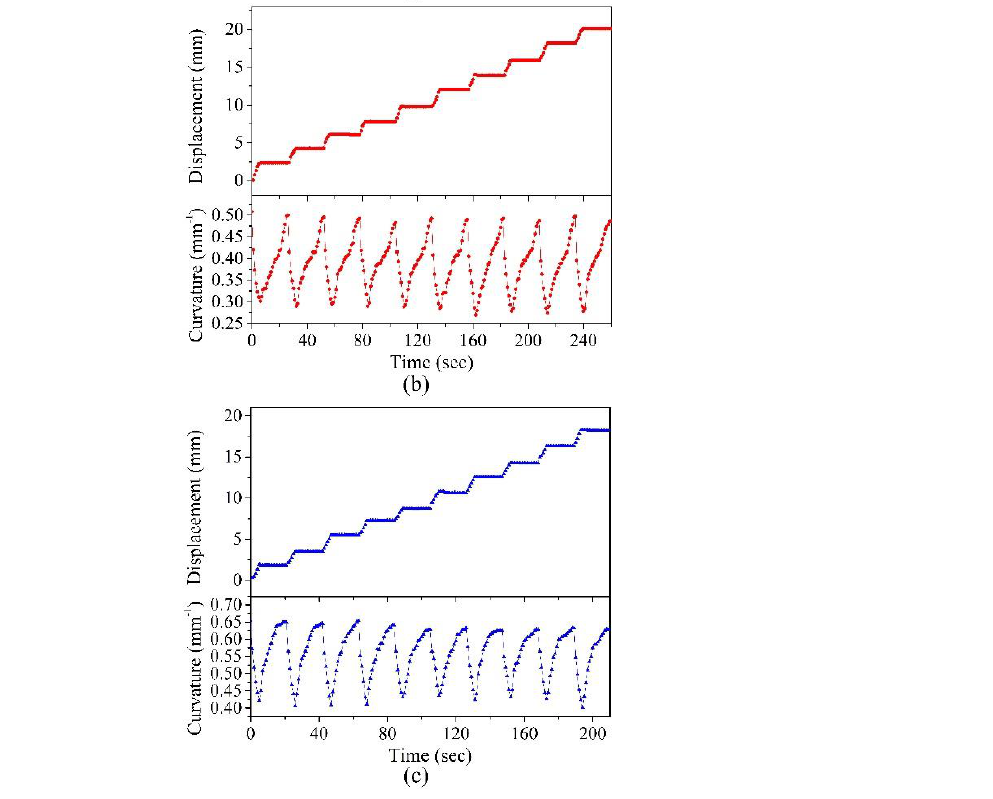
Figure 11. Measured transient displacement and the measured actuators curvature change in ( a ) Device-A, ( b ) Device-B, and ( c ) Device-C for 10 actuation cycles. The NIR light intensity is 2.4 W/cm 2 .